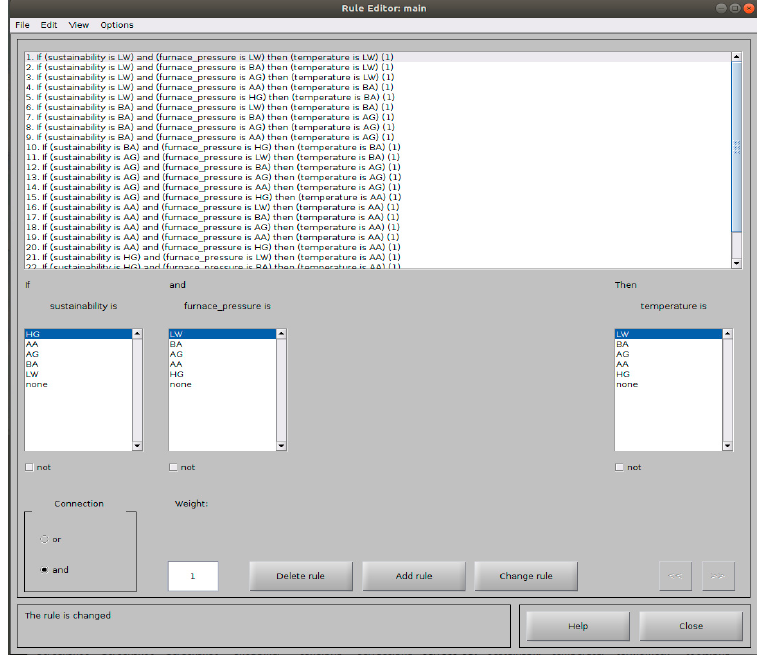
Appl. Sci. 2021 , 11 , x FOR PEER REVIEW Figure 5. Fuzzy knowledge base for input and output parameters. Figure 5. Fuzzy knowledge base for input and output parameters.